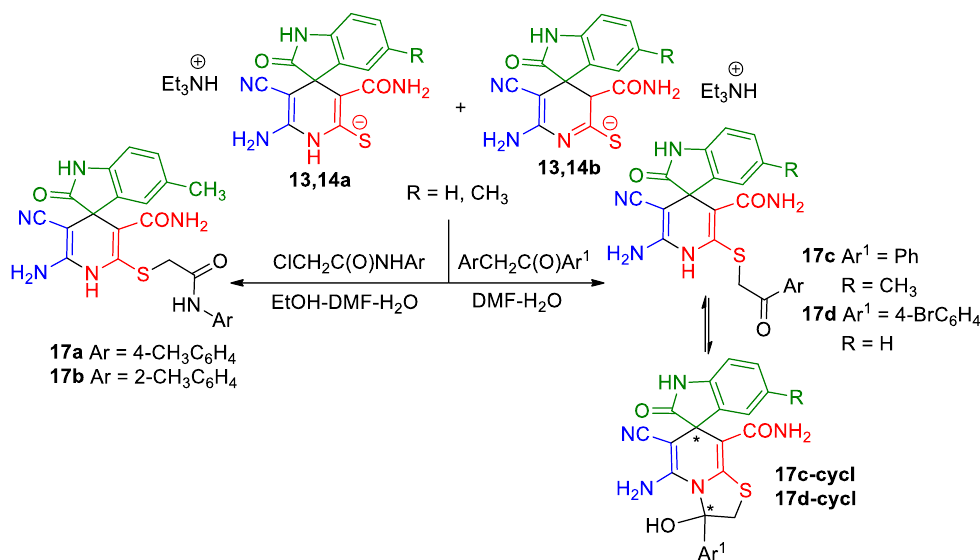
Scheme 7. Alkylation of thiolates 13 and 14 . An asterisk (*) marks the chiral centers in the mole- cules.